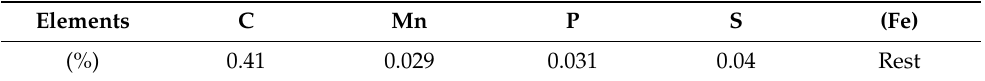
Table 1. Elemental composition of soft-cast steel used for corrosion experiments.